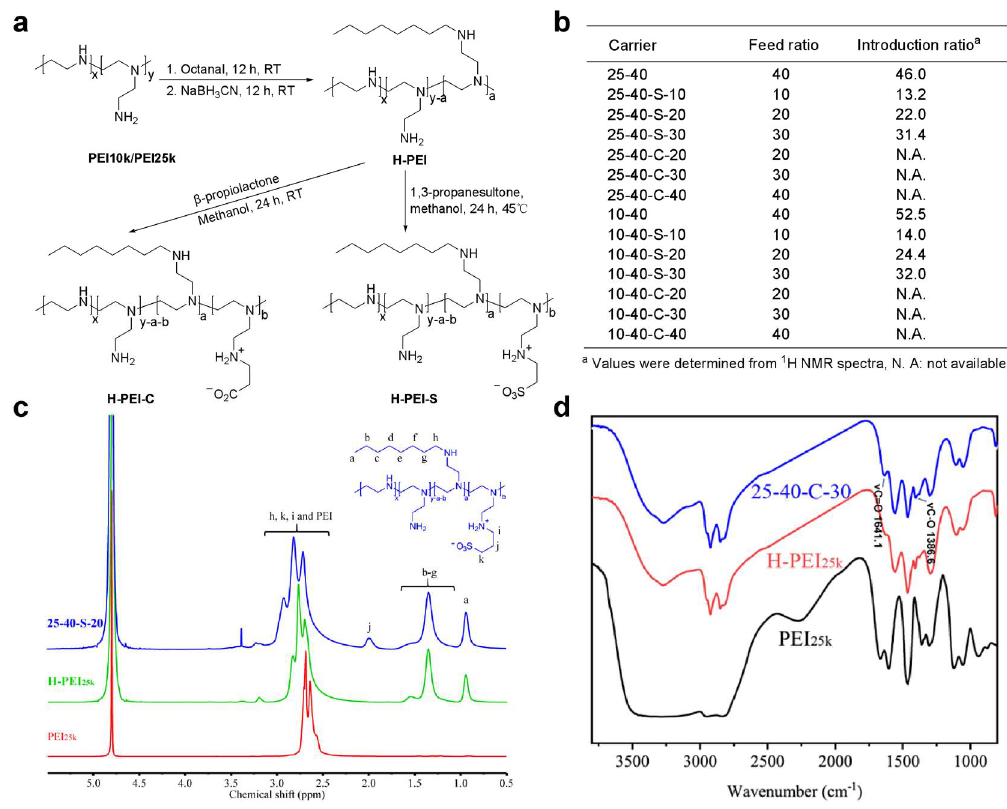
Figure 1. ( a ) Synthesis of H-zPEIs. ( b ) H-zPEIs with different zwitterion modification degrees. Final modified PEIs were named by the Mw of PEI, the octanylation degree, the zwitterion